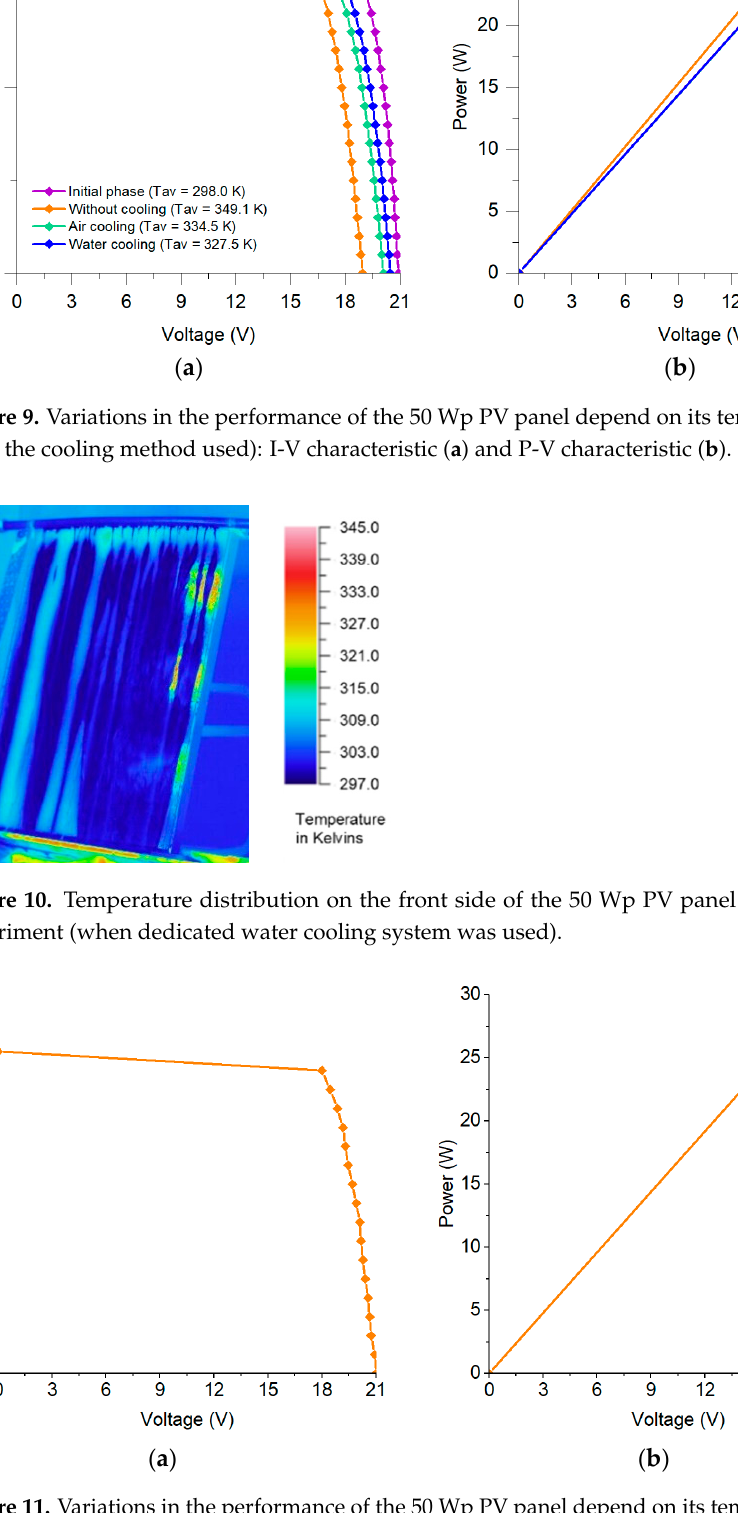
Figure 11. Variations in the performance of the 50 Wp PV panel depend on its temperature (when the prototype of water cooling system was installed and used): I-V characteristic ( a ) and P-V char- acteristic ( b